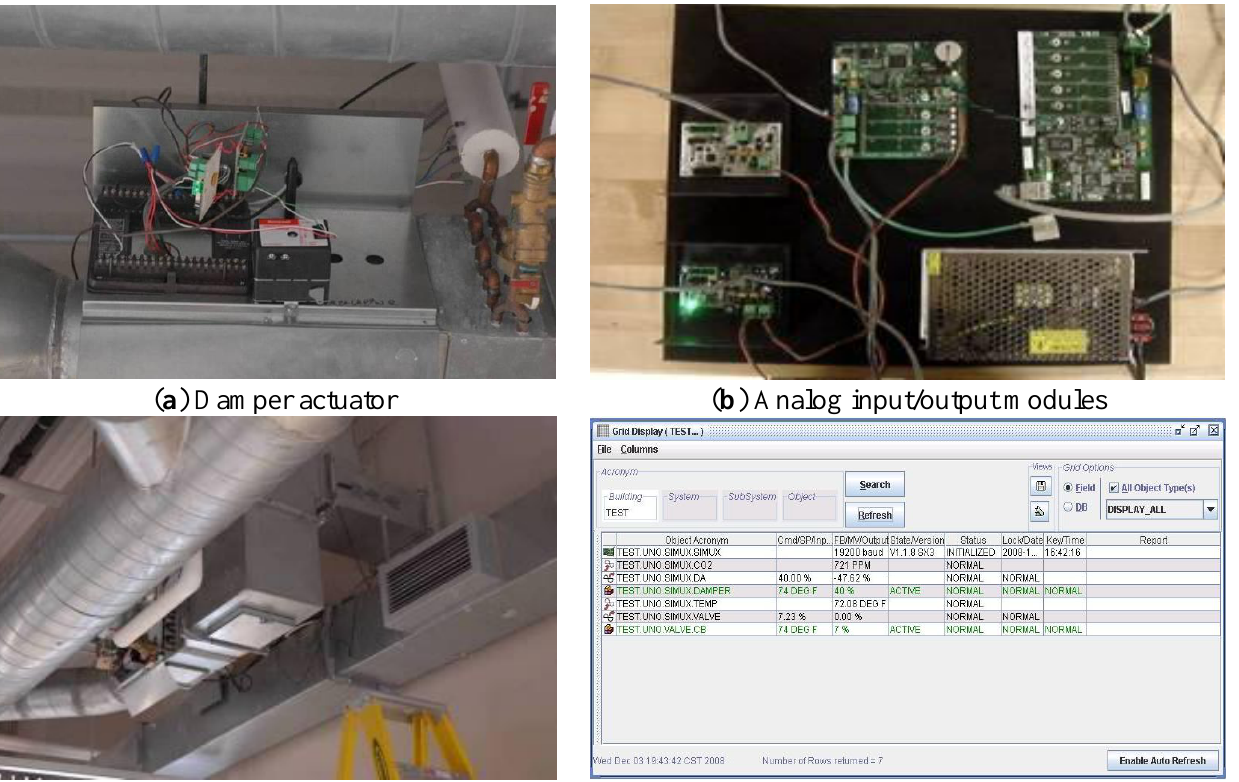
Figure 6. View of the VAV terminal control system.